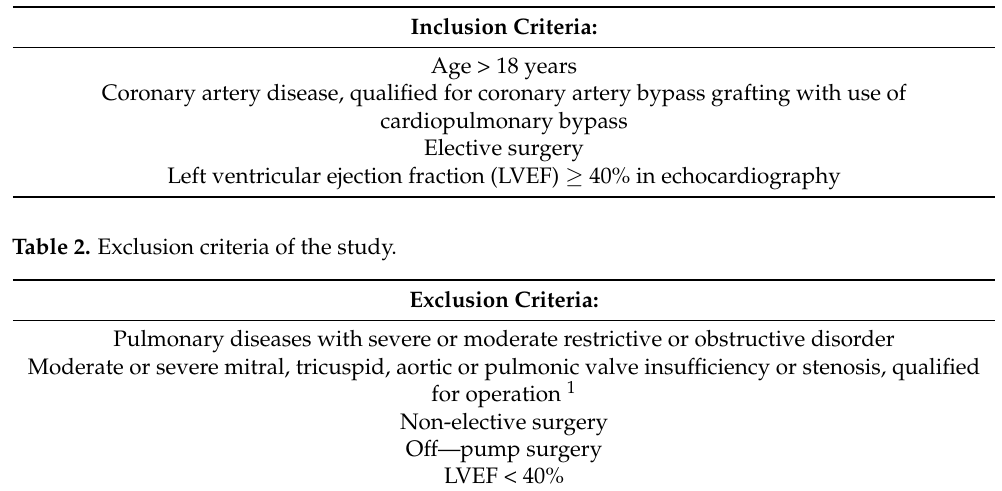
Table 1. Inclusion criteria of the study.